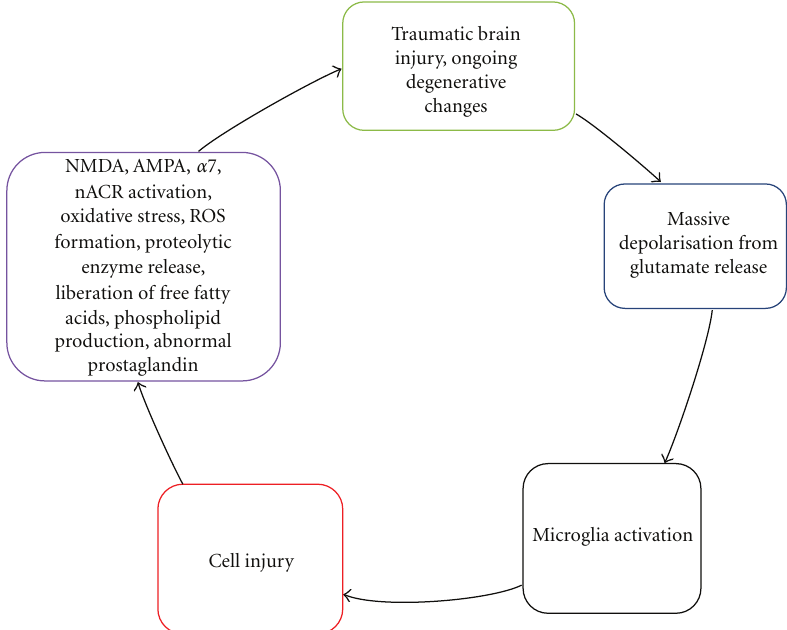
Figure 2: Sequential events of secondary injury in TBI. This includes variety of processes such as depolarization, disruption of ionic homeostasis and release of neurotransmitters, lipid degradation, and oxidative stress. These events are a result of interaction between the excitatory amino acid released with an influx of oxygen-free radicals that ultimately set up NMDA, AMPA, α 7, and nACR to sustain the unstable environment for cell injury and degenerative